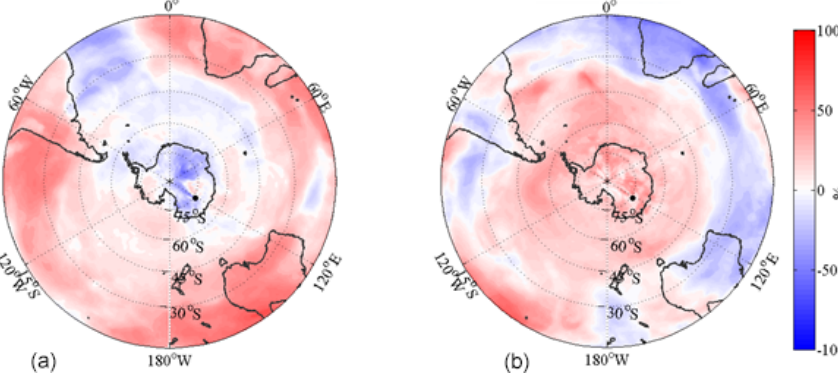
Figure 14. The relative difference, RD, Eq. (19), of transport for the two lowest layers ( > 1000ma.g.l.) between the highest and lowest 10% of (a) eBC concentration and (b) single-scattering albedo. Positive values indicate a relative increase in transport and negative values a decreased transport from a given area by the highest 10% of